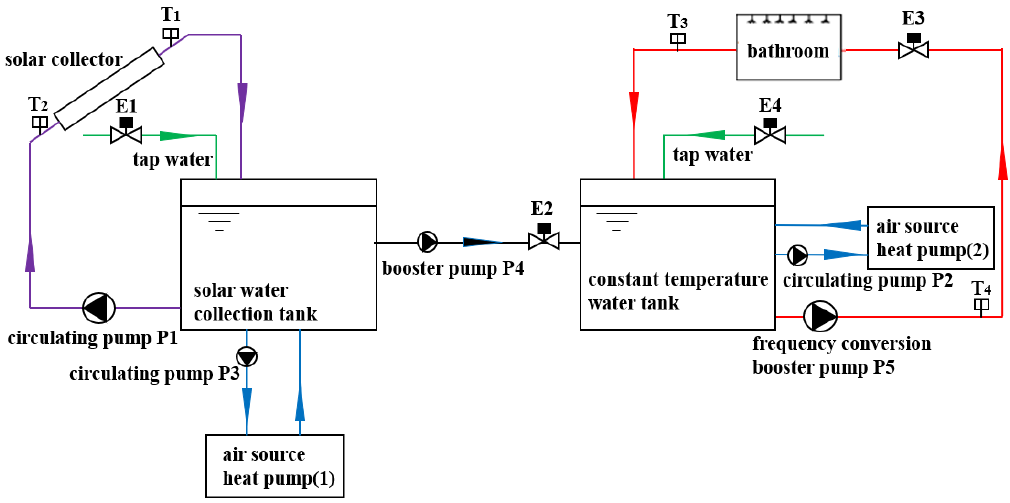
Figure 2. Schematic diagram of the rebuilt SA-ASHP water heating